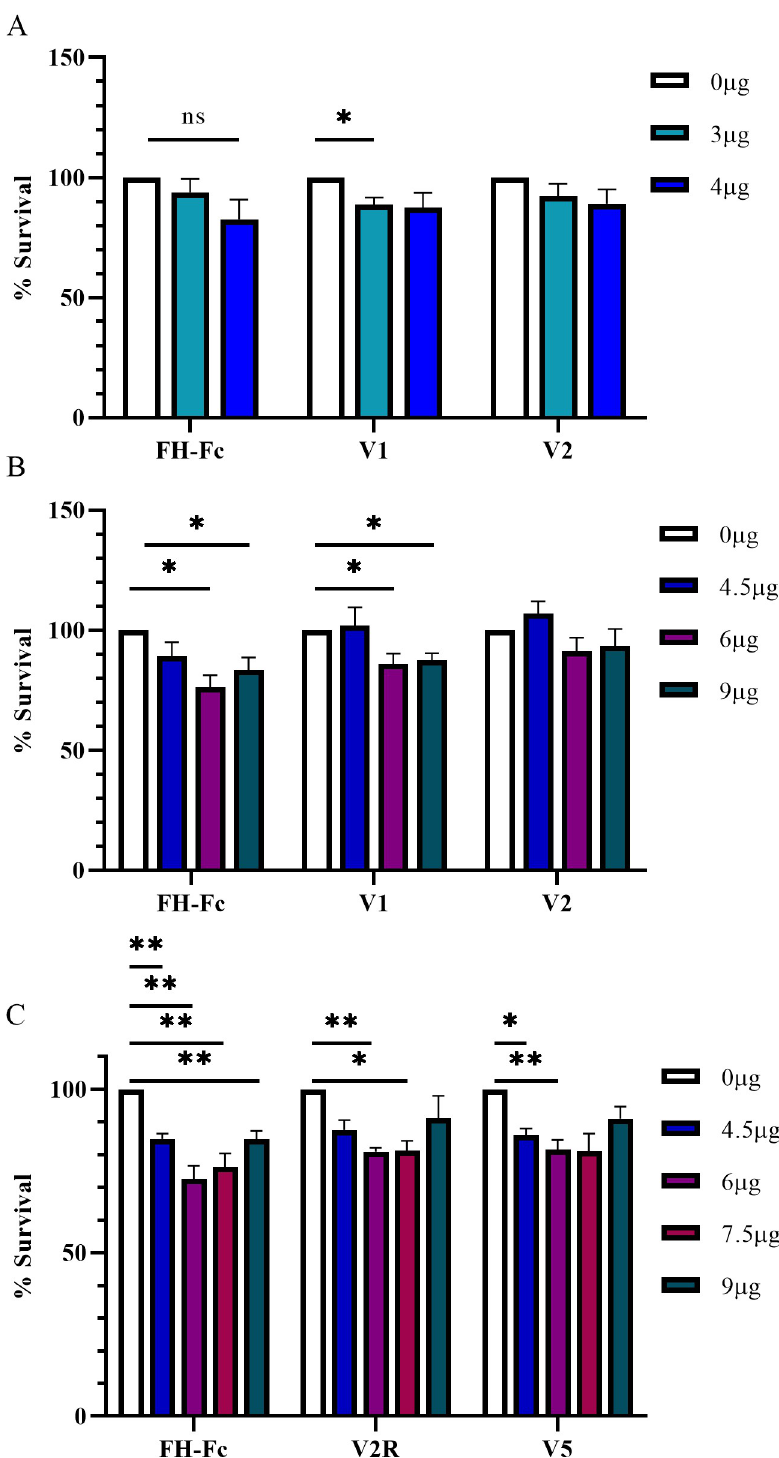
Fig 8. Fusion protein treatment reduces survival of CA-MRSA R7. CA-MRSA R7 were incubated with NHS ± fusion protein for 15 minutes then challenged with polymorphonuclear cells at a ratio of 1 PMN per 10 bacteria. After rotating at 37˚C for 75 minutes, samples were serially diluted and plated. A, In 2.5% NHS. B, In 5% NHS. C, In 10% NHS. Data represent the mean ± SEM of at least four independent experiments ( � p < 0.05, �� p �